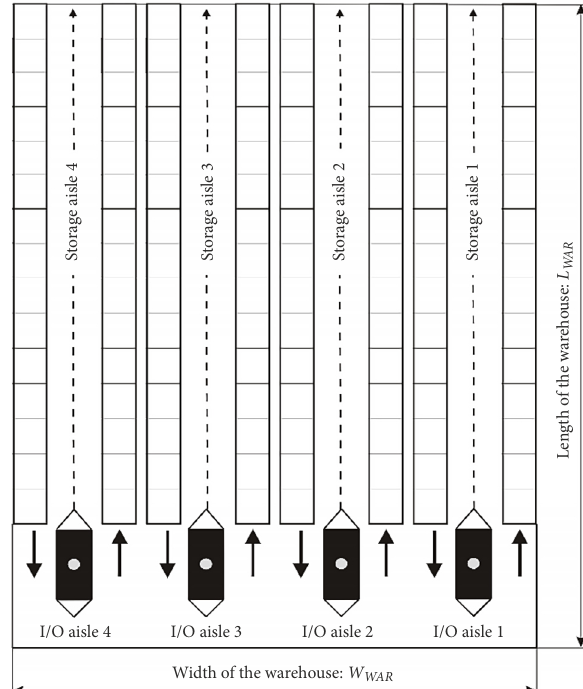
Figure 4. The SR with storage compartments – top view (Lerher et al.